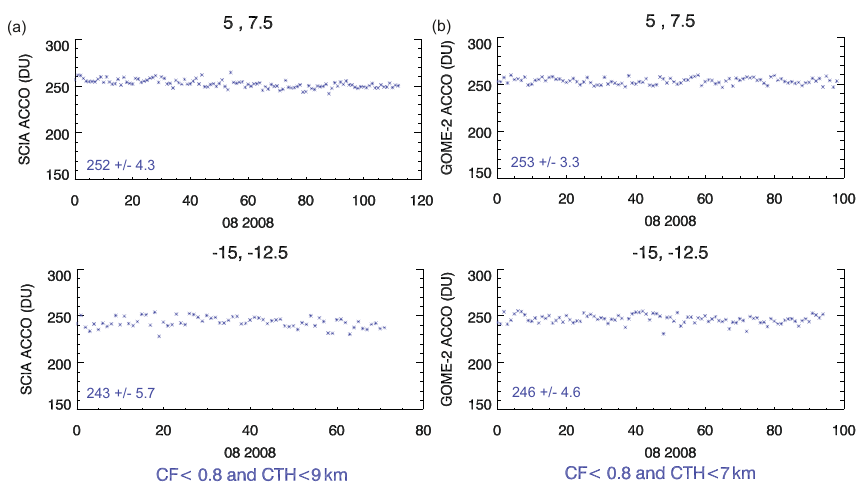
Figure 2. (a) Above-cloud column ozone (ACCO for the latitude bands 5–7.5 ◦ N and 15–12.5 ◦ S (CF > 0.8 and CTH > 9km) from SCIA- MACHY (using OCRA/SACURA for cloud detection). (b) Above-cloud column ozone (ACCO for the latitude bands 5–7.5 ◦ N and 15– 12.5 ◦ S (CF > 0.8 and CTH > 9km) from GOME-2 (using FRESCO for cloud detection) in August 2008. The 1 σ standard deviation is less than 5DU.